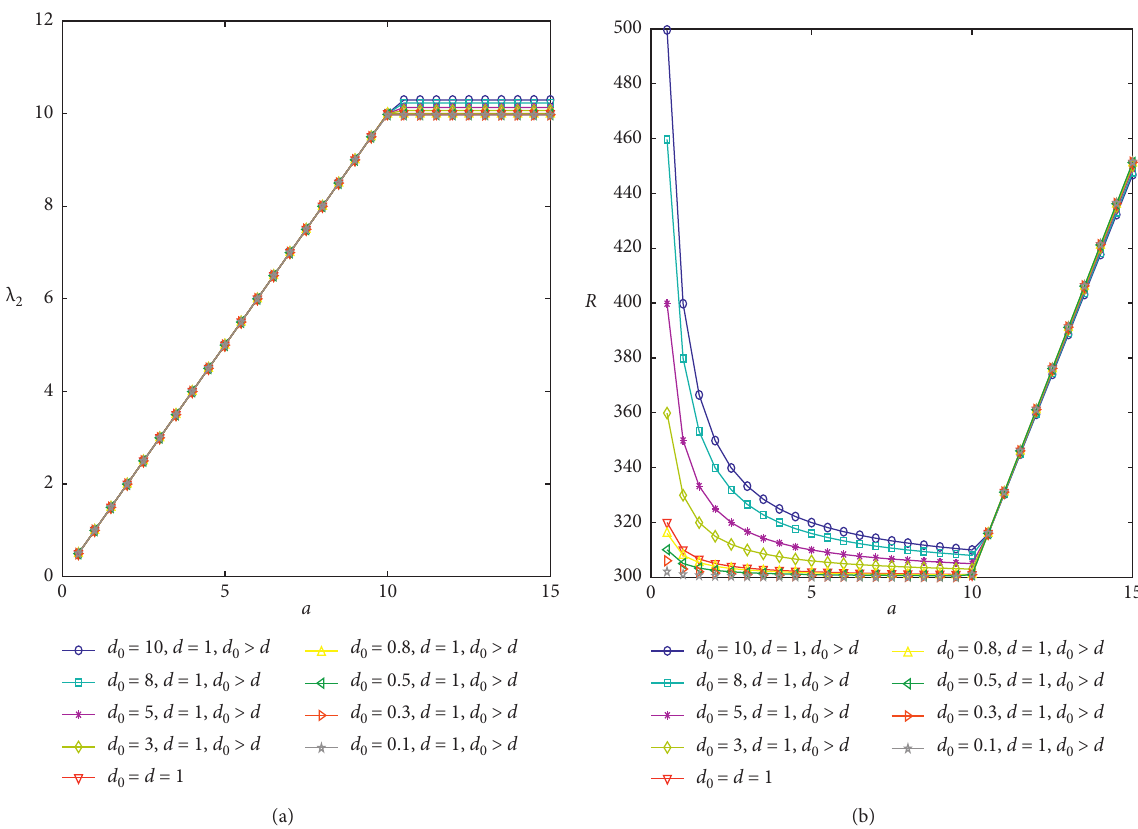
Figure 4: The synchronizability of multilayer star networks vs . varying the intralayer coupling strength a ( N � 300, M � 10, and d � 1). (a) λ with respect to varying a for different d 0 . (b) R with respect to varying a for different d 0 .